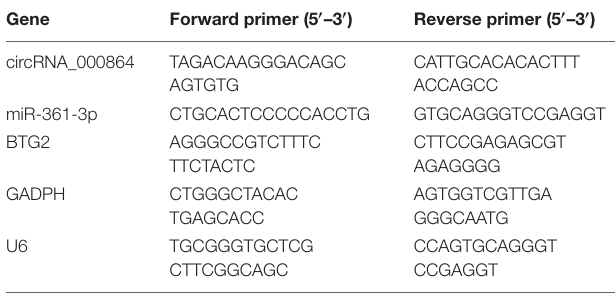
TABLE 1 | Primer sequences of